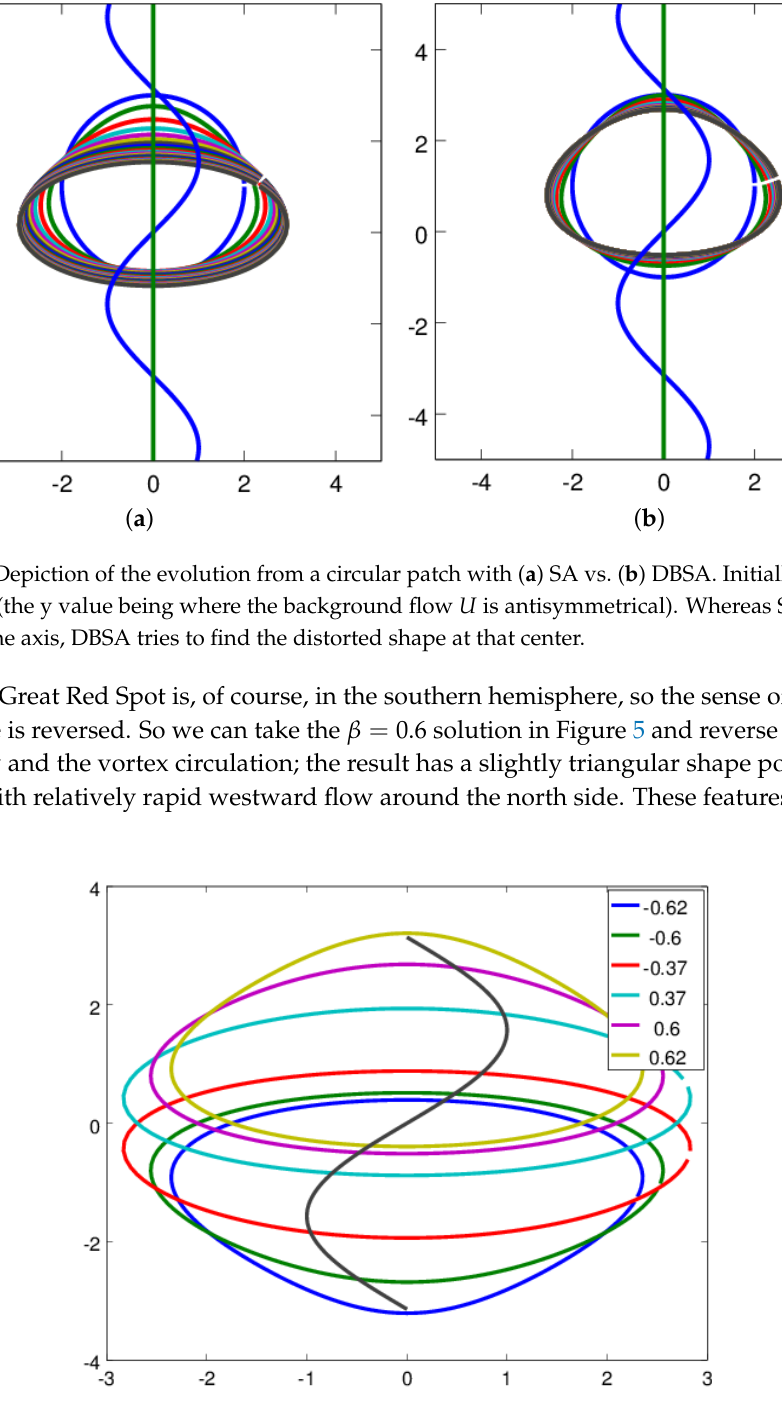
Figure 5. Vortex shape as a function of β , with q 0 and the area fixed. The vortex is initially centered at y 0 = − 1.25, − 1, − 0.5,0.5,1,1.25; labels give the value of β (to be compared with max | U (cid:48)(cid:48) ( y ) | = 1) for which this would be the equilibrium